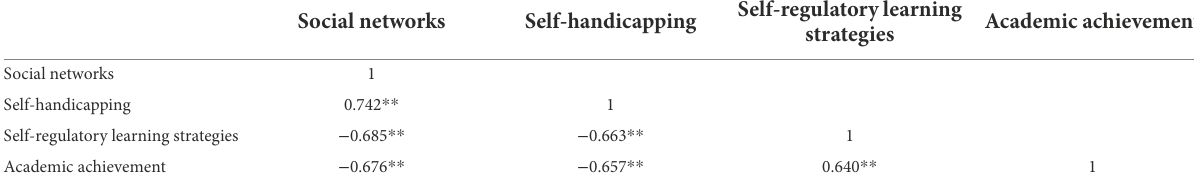
TABLE 4 Correlation between research variables.